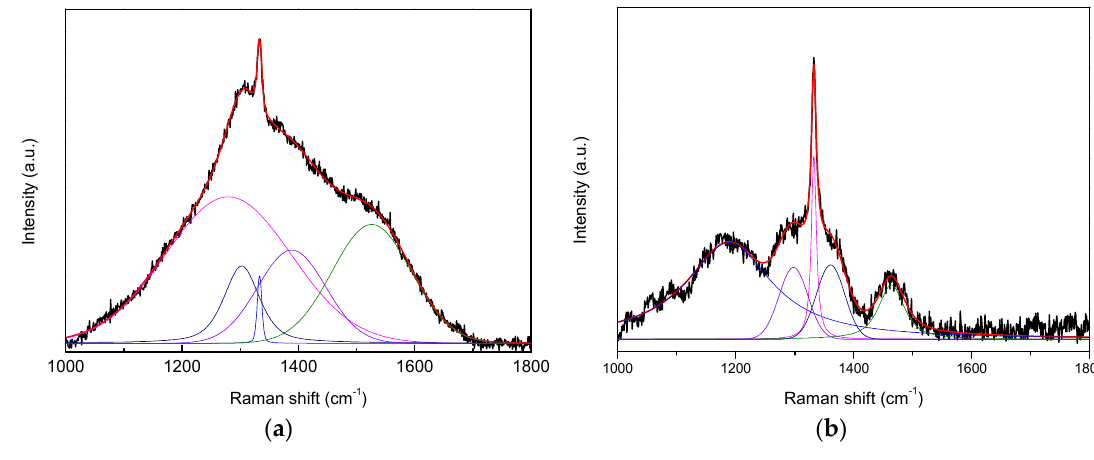
Figure 2. Raman spectra of the ( a ) MCD and ( b ) RMCD coating.